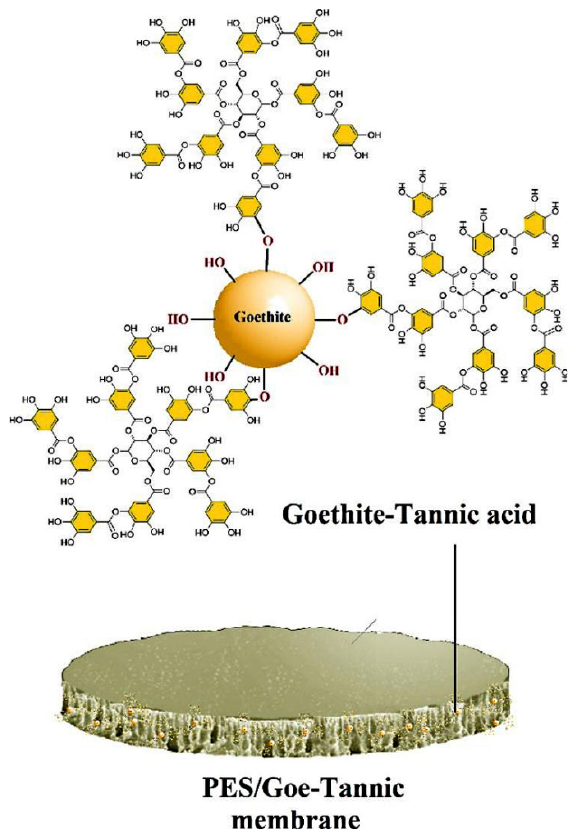
Figure 3. Illustration of Goe-tannic acid nanoparticles embedded in PES membrane [48]. (Copyright 2020. Reproduced with permission from Elsevier.)